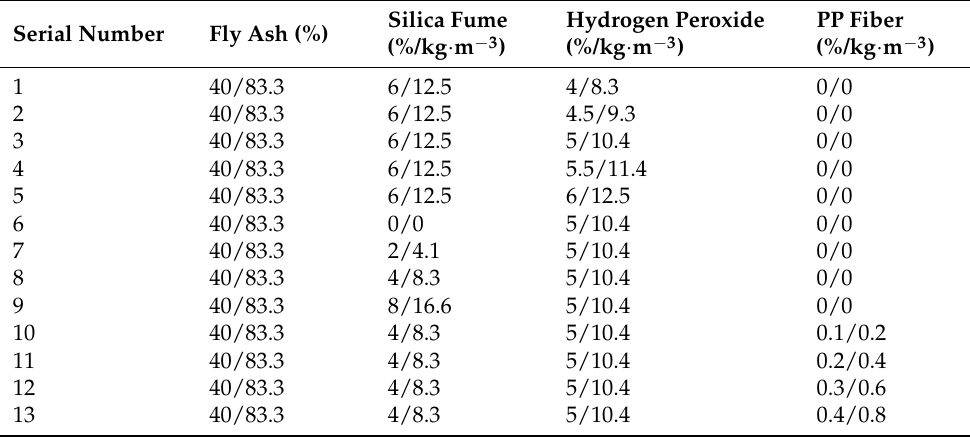
Table 4. Fly ash foam concrete test mix